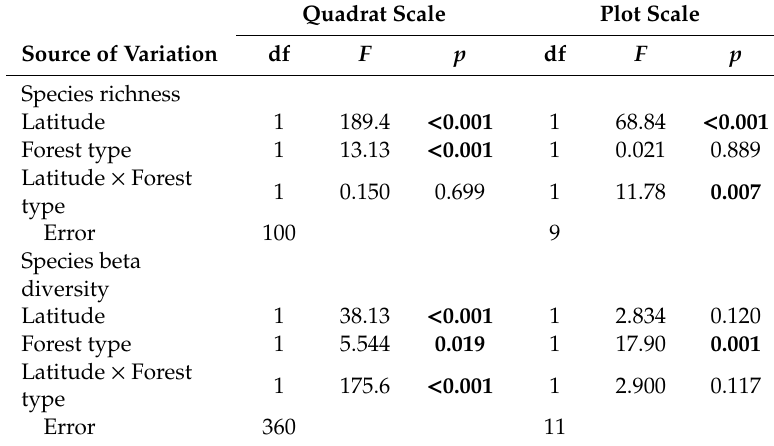
Table 3. Results of the two-way ANOVA for influences of forest type (broadleaf vs. coniferous) and latitude (high vs. low) on species alpha and beta diversity at the quadrat and plot